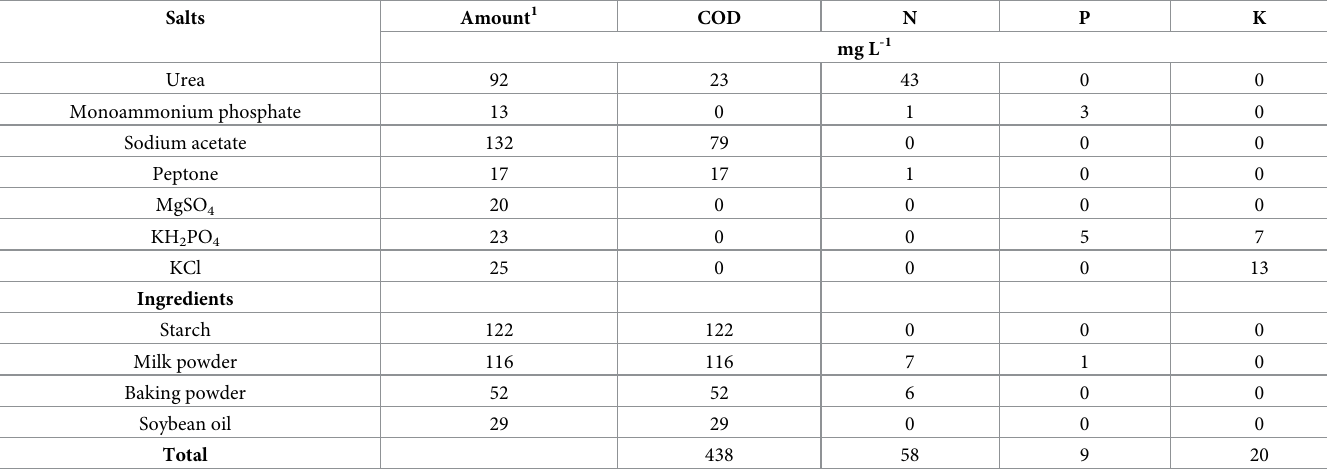
Table 2. Compounds and their theoretical concentrations to prepare 1 liter of synthetic municipal wastewater. Source: Adapted from Nopens [13]. Salts